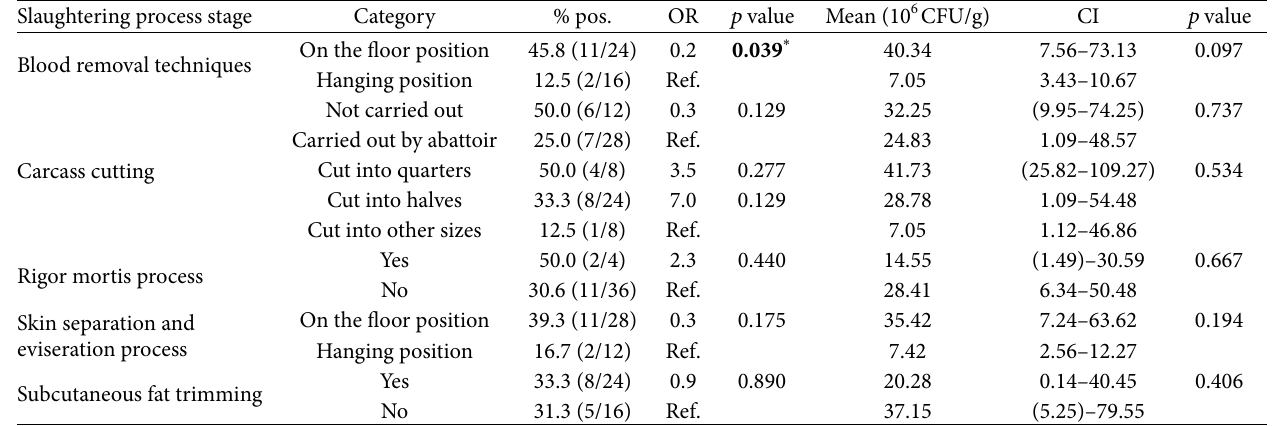
Table 3: MPN Escherichia coli